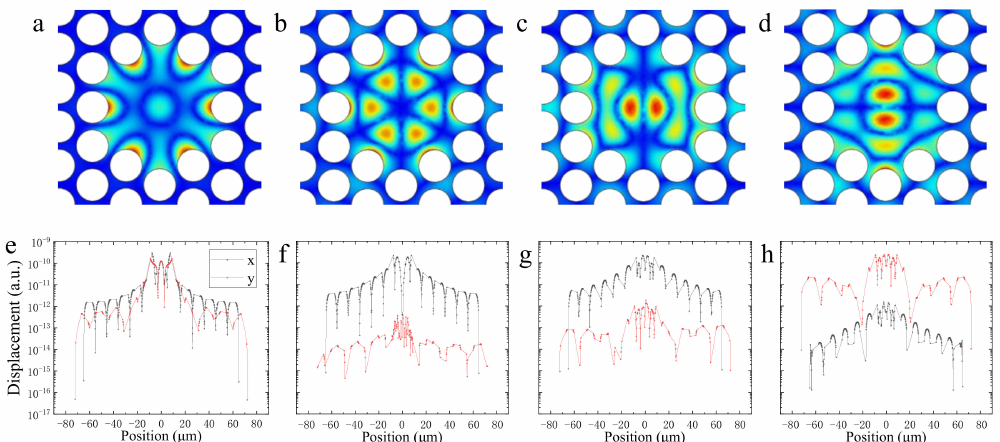
Figure 2. ( a – d ), Mode shapes of the four localized defect modes; ( e – h ) corresponding projections of the absolute value of displacement fields along the x- (black) and y-directions